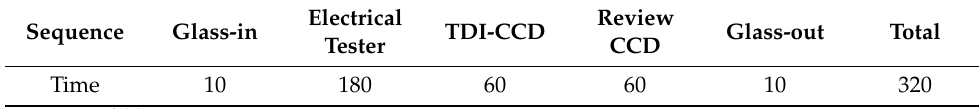
Figure 4. An architecture of open/short sensor unit engaged with the automatic optical inspection, ( A ) glass-in, ( B ) OS sensor unit, ( C ) scan TDI-CCD, ( D ) review CCD, and ( E ) glass-out. Table 1. The 8.5 generation glass cycle time illustrates the time chart.